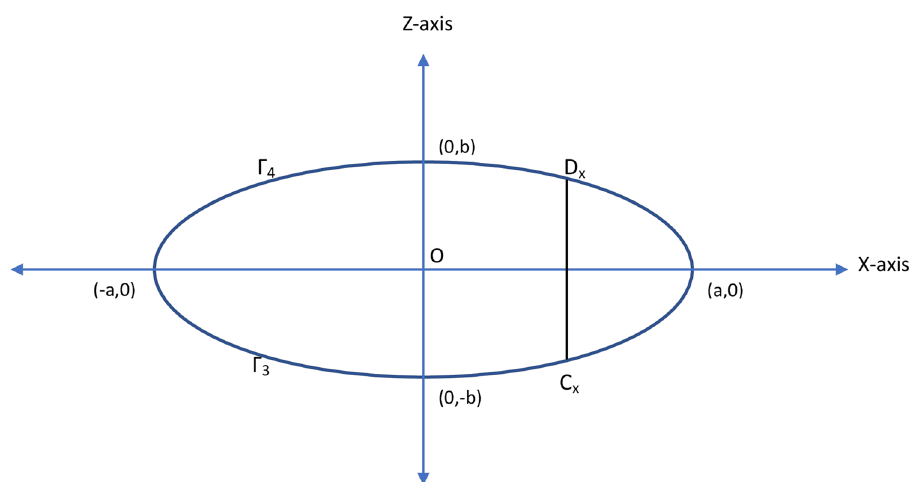
Figure 2: Elliptic domain.